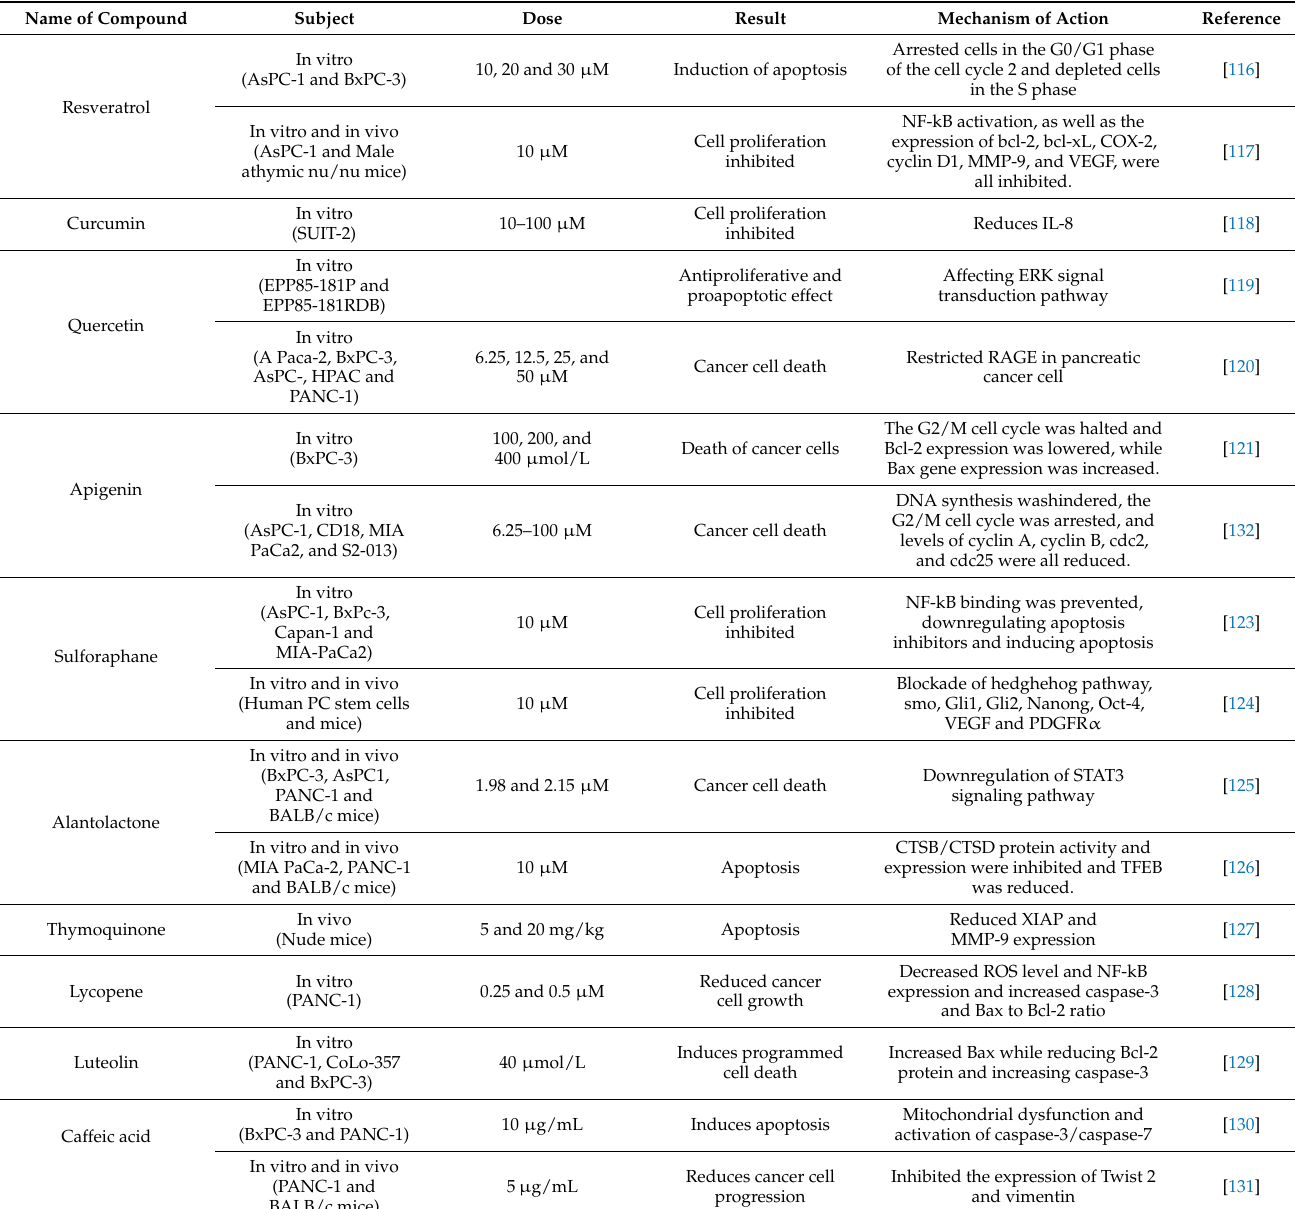
Table 4. Natural small molecules in pancreatic cancer